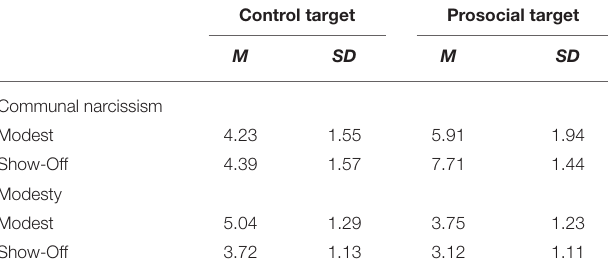
TABLE 6 | Mean target communal narcissism and modesty ratings per condition in Experiment